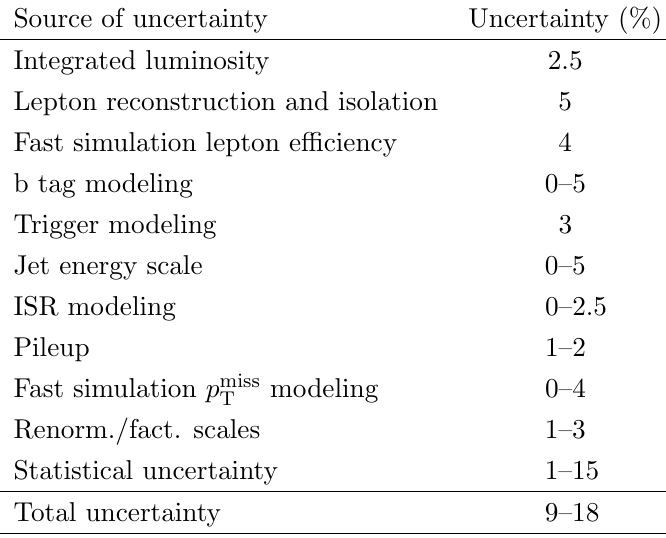
Table 6 . Systematic uncertainties taken into account for the signal yields and their typical